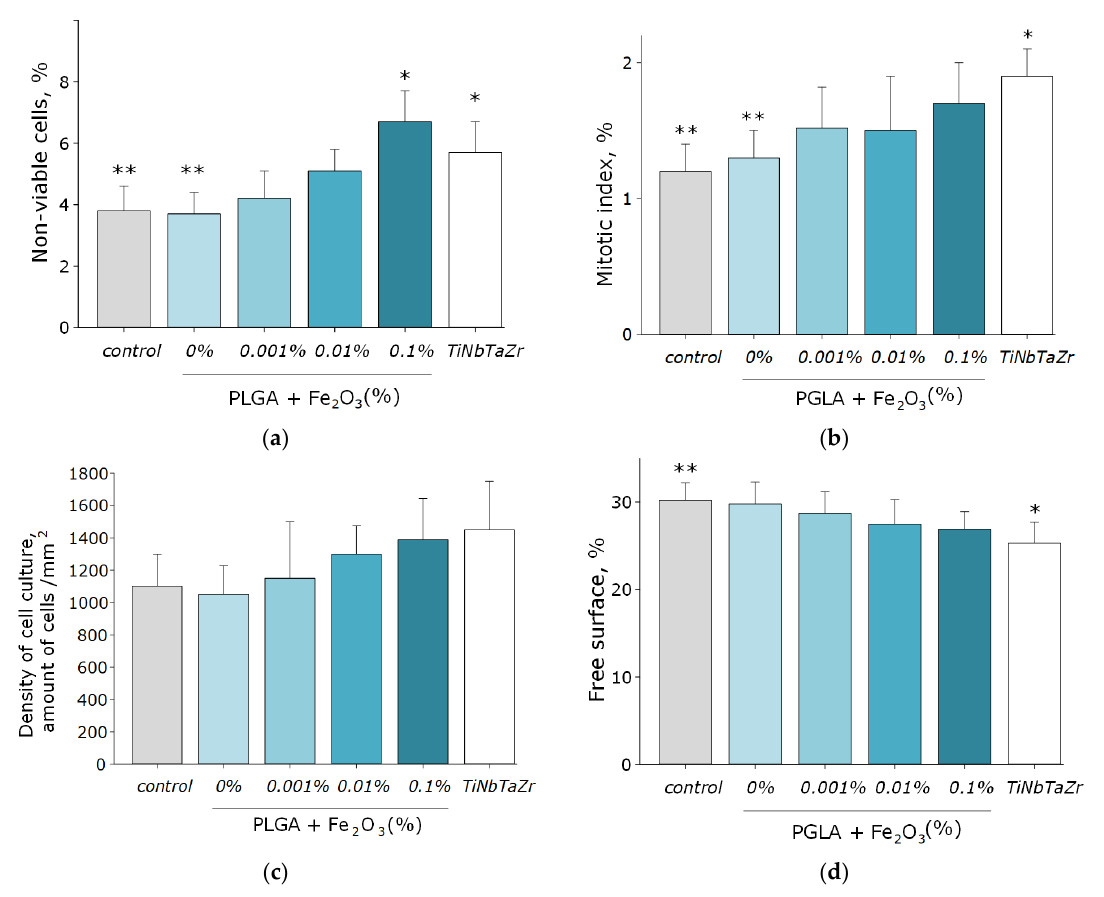
Figure 10. Results of evaluation of the cytotoxic effect of the nanocomposite based on PLGA with iron oxide nanoparticles on cultures of eukaryotic cells of the SH-SY5Y line. Proportion of non-viable cells in culture ( a ); mitotic index ( b ); cell culture density ( c ); surface of the composite free of cells ( d ). *—statistically significant differences compared with the control group ( p < 0.05). **—statistically significant differences compared with the “TiNbTaZr” group ( p < 0.05). Data are presented as mean ± standard error of the mean.